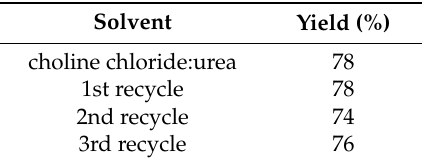
Table 1. Influence of DES recycle on the yield of the final product.